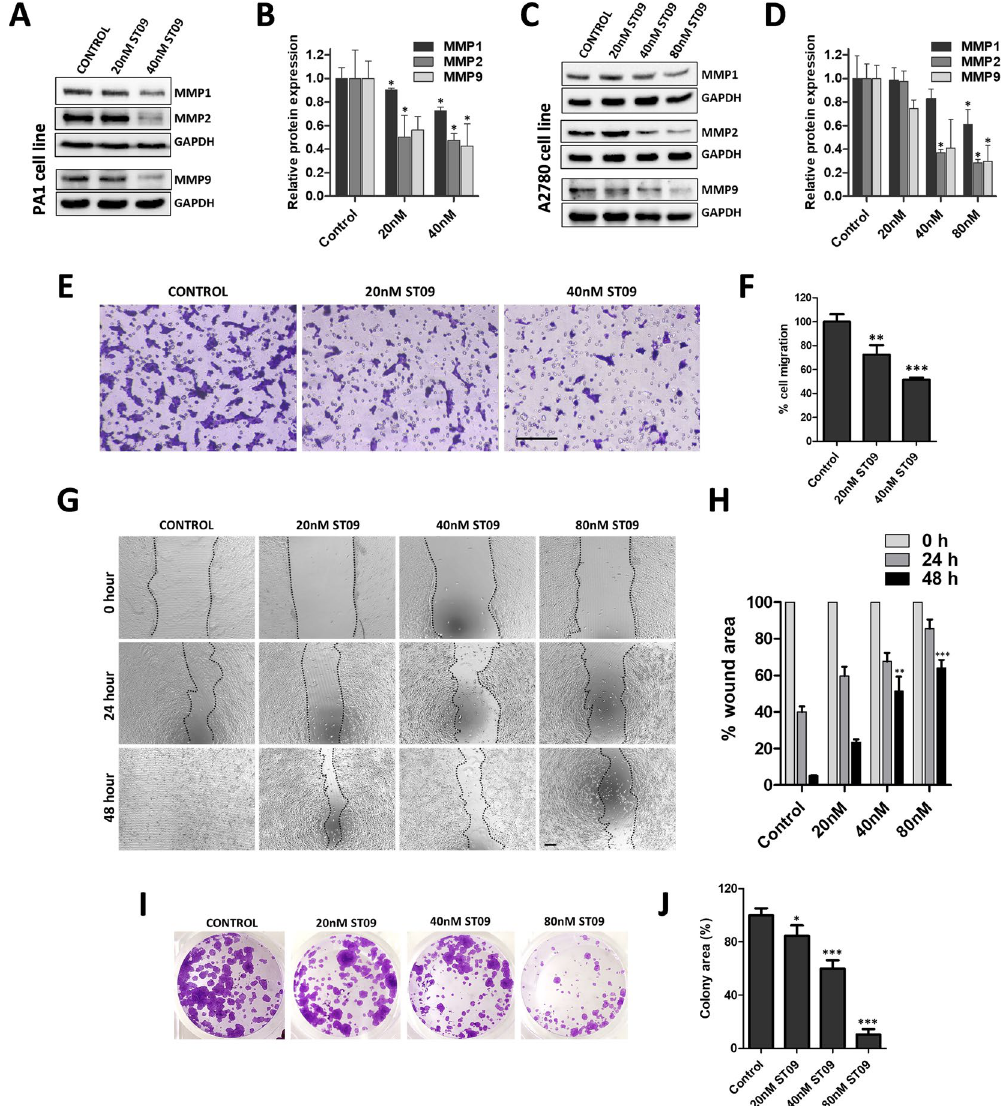
Figure 5. ST09 downregulates downstream DDR1 target, MMPs inhibiting migration, wound closure and colony-forming properties in PA1 cells. ( A ) Expression of MMP proteins and ( B) corresponding quantification in PA1 cells treated with increasing concentrations of ST09 for 48 h. ( C) Expression of MMP proteins and ( D) Corresponding quantification of A2780 cells treated with increasing concentrations of ST09 for 48 h. ( E) Migration assay images and ( F) corresponding quantification of the percentage migrated ST09-treated PA1 cells. Scale bar represents 200 µm ( G) Wound healing assay images and ( H) corresponding quantification representing percentage wound area at 0, 24 and 48 h time points of PA1 cells treated with increasing concentrations of ST09. Scale bar represents 200 µm ( I) Clonogenic assay images and ( J) corresponding quantification representing colony area percentage of PA1 cells treated with increasing concentrations of ST09. Uncropped gel images are provided in the supplementary information. All bar graphs are plotted as mean ± SD from three independent experiments. Significance was plotted based on p values, and represented as *( p -value < 0.05), **( p -value < 0.01), ***( p -value < 0.001) and ****( p -value <